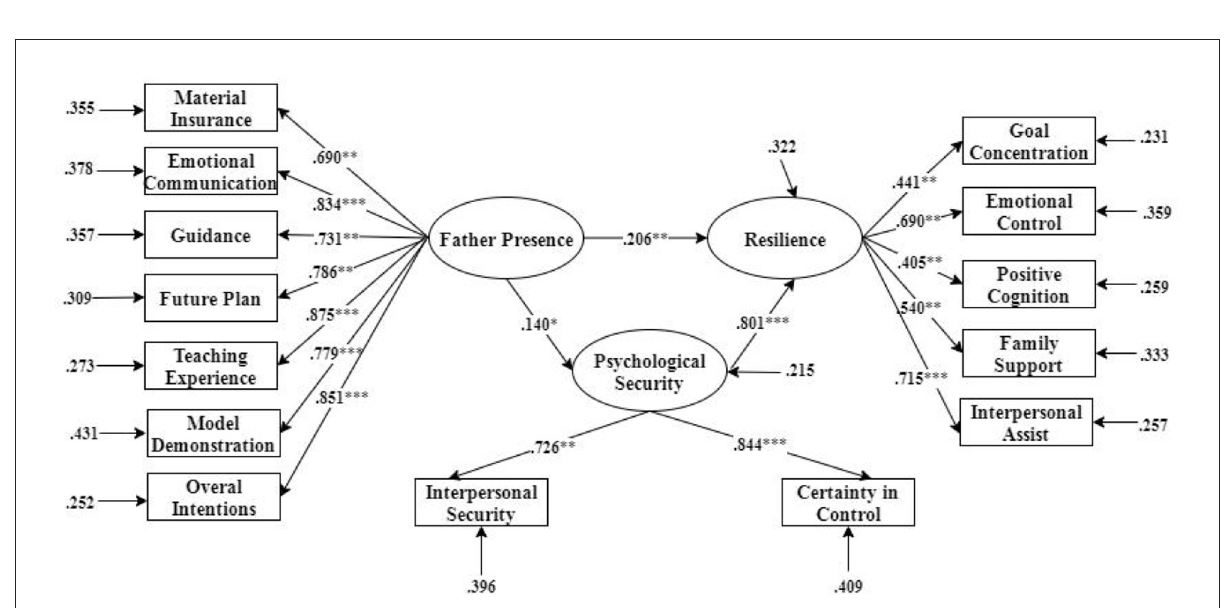
FIGURE2 Mediating model of psychological security between father presence and resilience. * p < 0.05; ** p < 0.01; *** p < 0.001.